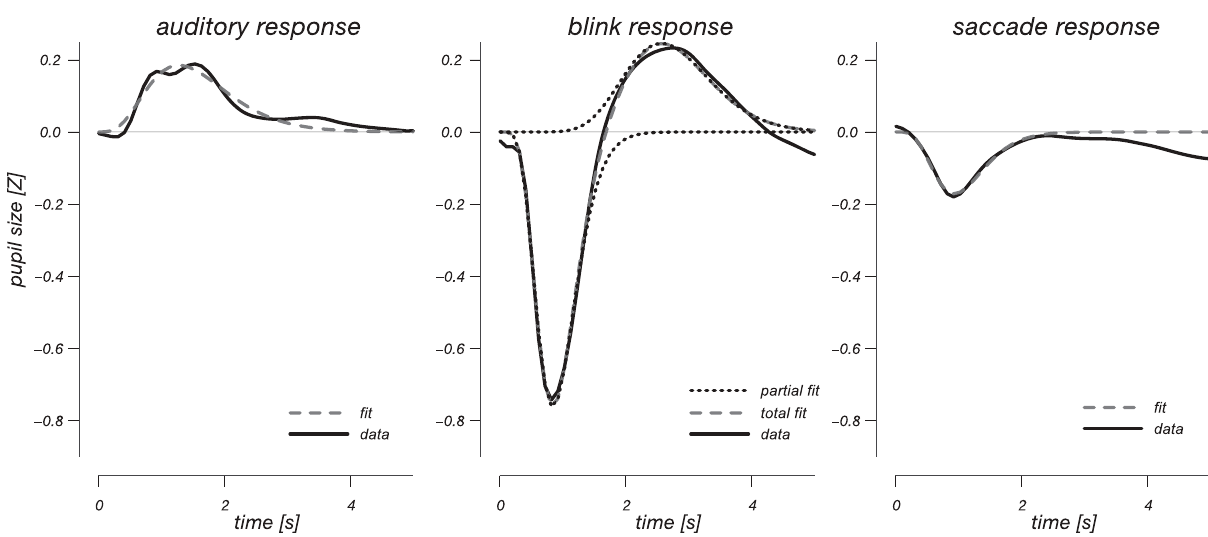
Fig 5. Response curves fit to gamma distribution probability density functions. The same scale is used for all curves. The data, averaged across 4 conditions for event, blink and saccade response profile panels, are plotted in solid black lines, whereas the best-fitting curve is plotted using dashed grey lines. The dotted lines in the blink panel show the two gamma shapes that together define the full biphasic shape, listed separately in Tables 1 & 2.